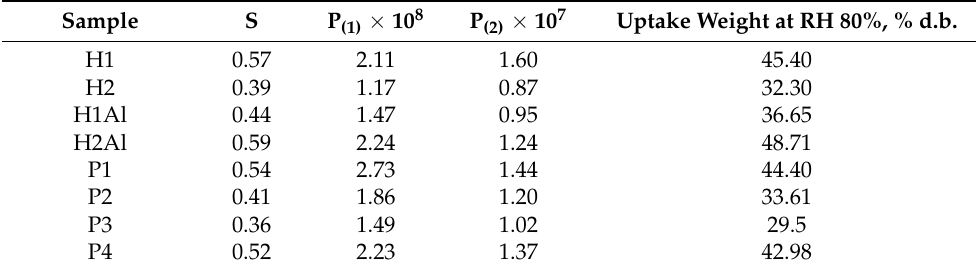
Table 6. Sorption and permeability coefficients (cm 2 s − 1 ), uptake weight at RH